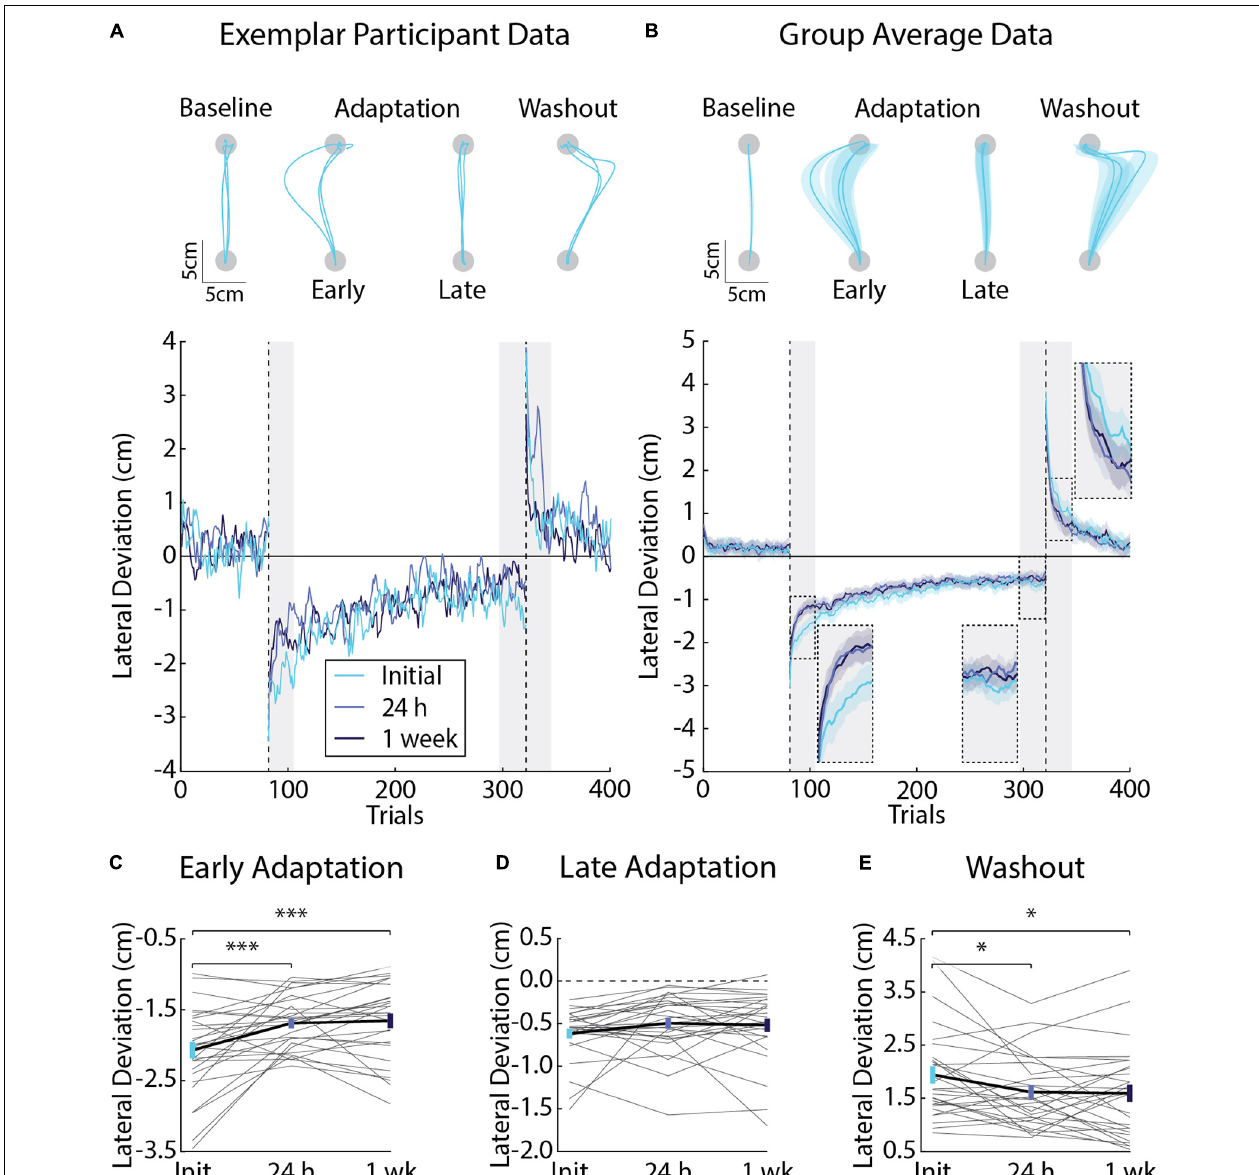
FIGURE 2 | Differences in movement kinematics (peak lateral deviations) across testing sessions ( Experiment 1 ). (A) Hand paths and adaptation profiles from an exemplar participant in Experiment 1 . Hand paths were sampled at random for three trials in the baseline phase. The first and last three trials are shown for the adaptation phase. The first three trials are shown for the washout phase. Peak lateral deviations (cm) were measured on each trial and plotted for the exemplar participant. (B) Group average adaptation profiles ( n = 28, 12 female). Lines represent the mean and shaded regions the SEM. Adaptation was measured in Early Adaptation , Late Adaptation , and Washout (shaded gray regions and inset panels). (C) Comparisons of the average peak lateral deviations measured in Early Adaptation in each session (Initial, 24 h, and 1 week). Gray lines indicate individual participant averages measured across sessions. Error-bars indicate mean and SEM during Early Adaptation . (D) Average peak lateral deviations in Late Adaptation . (E) Average peak lateral deviation in Washout . Data in panels (D,E) are represented in the same manner as panel (C) . ∗ p < 0.05 and ∗∗∗ p < 0.001 after Bonferroni corrections (corrected for 3